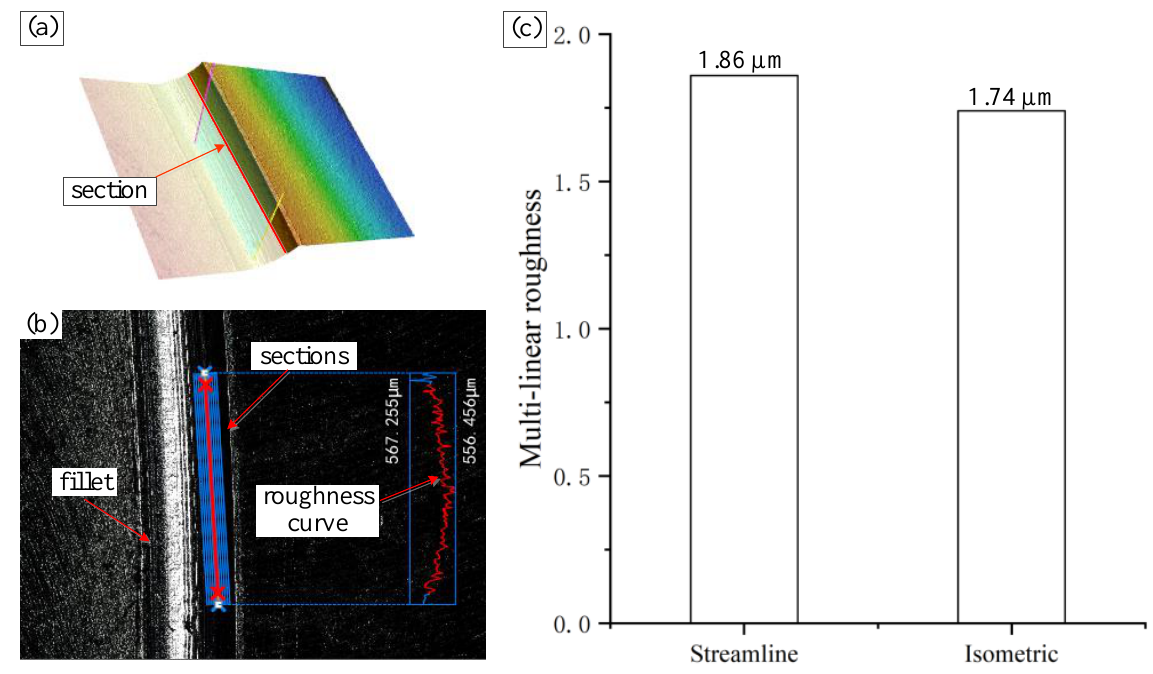
Figure 14. ( a ) Micro-fillet 3D image, ( b ) multilinear roughness measurement and ( c ) multilinear roughness result.